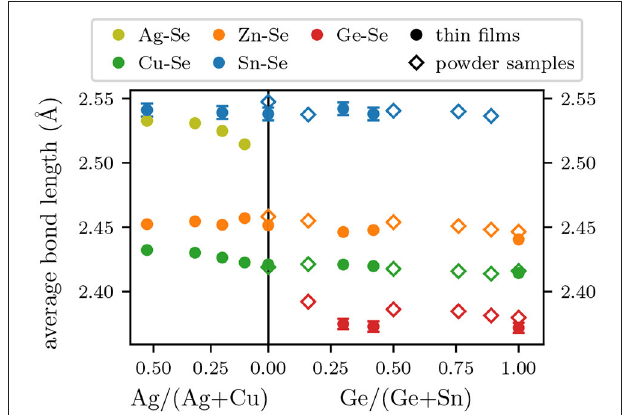
FIGURE 3 | Lattice parameters a and c / 2 as a function of Ag/(Ag+Cu) (left) or Ge/(Sn+Ge) (right) with linear fits as gray lines. the anion sublattice adjusts to the different sizes of the